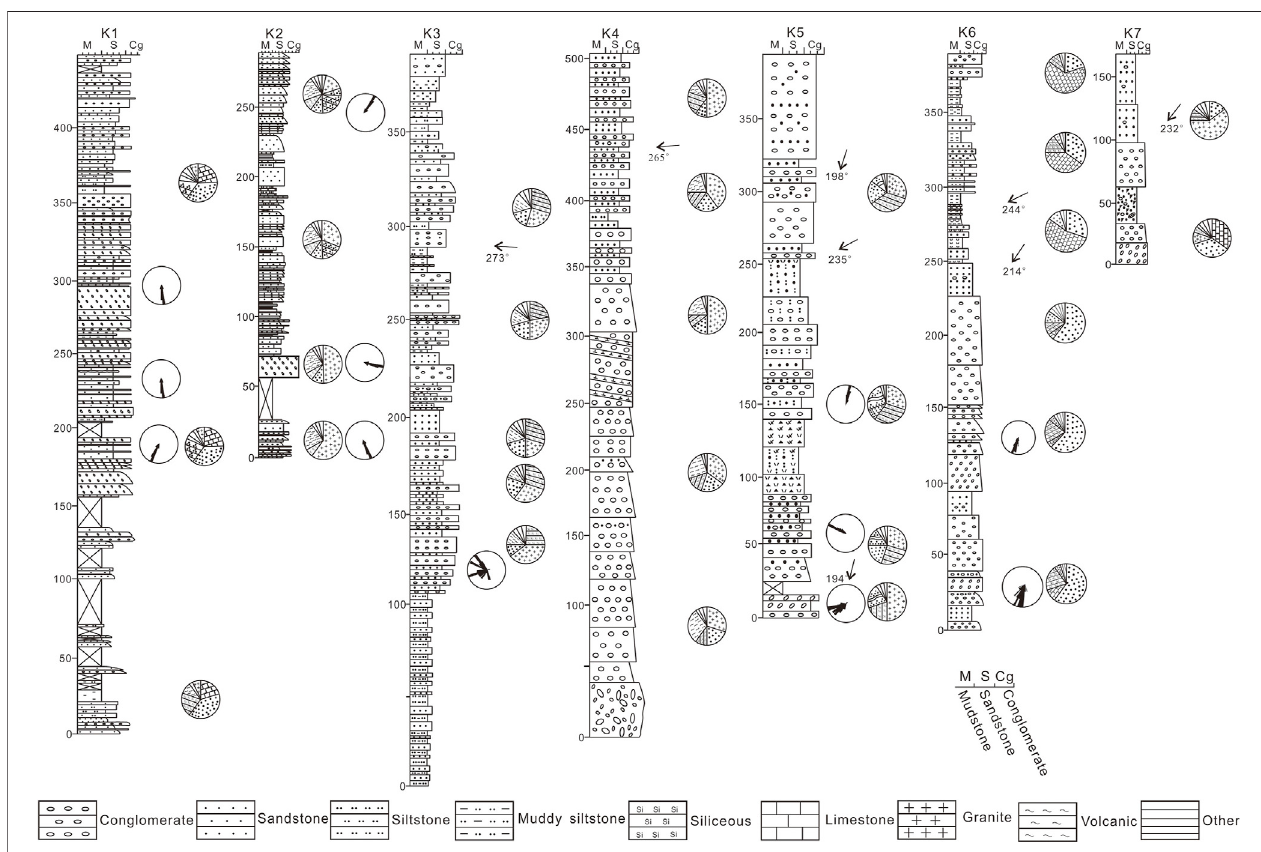
FIGURE 7| Palaeocurrent and conglomerate clast count statistical analysis of Gangdese conglomerate. Section locations shown in Figure 1 . Stratigraphic height is in meters.